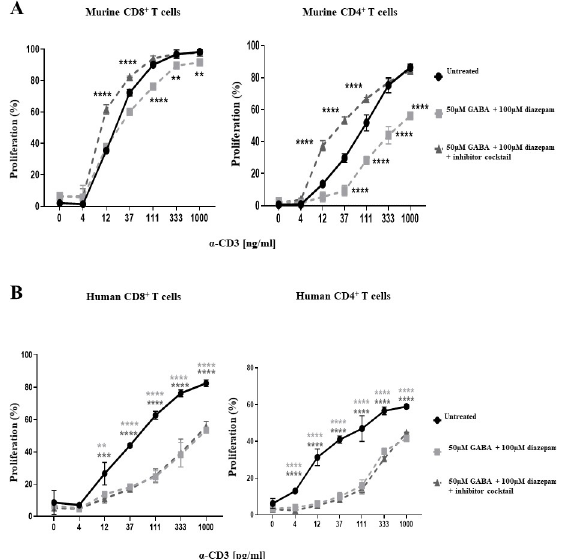
Fig 3. Diazepam inhibits mouse and human T cell proliferation via different pathways. Splenocytes and PBMC were treated with α -CD3, 50 μ M GABA, 100 μ M diazepam, and a cocktail of GABA(A)R inhibitors consisting of 100 μ M BMI and 50 μ M TPMPA. The reduction in proliferation under each condition as compared to a positive control of α -CD3 alone was assessed by flow cytometry following 48 hours of treatment for splenocytes, and 96 hours of treatment in PBMC. A . Treatment with the GABA(A)R inhibitor cocktail is able to rescue CD8+ and CD4+ T cell proliferation in murine T cells. B . Treatment cannot rescue proliferation in humans T cells. Data shown is from one representative experiment, with error bars (SD). Differences between groups were assessed by one-way ANOVA. � = p < 0.05. �� = p < 0.01. ��� = p < 0.001. ���� = p < 0.0001.